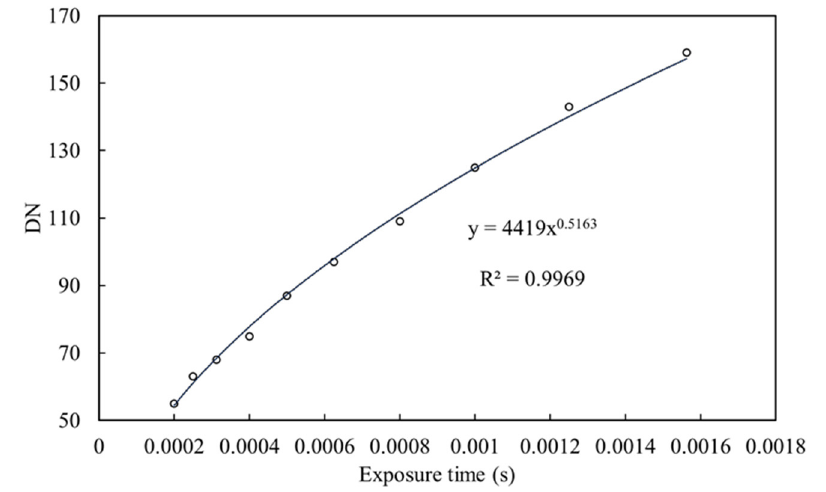
Figure 1. Scatterplot and fitting line of red band digital pixel number (DN) as a function of exposure time of a gray reference card with a fixed aperture (1/7.1) and ISO (125).